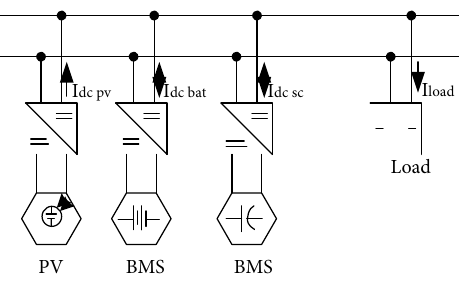
Figure 1: Implemented system block